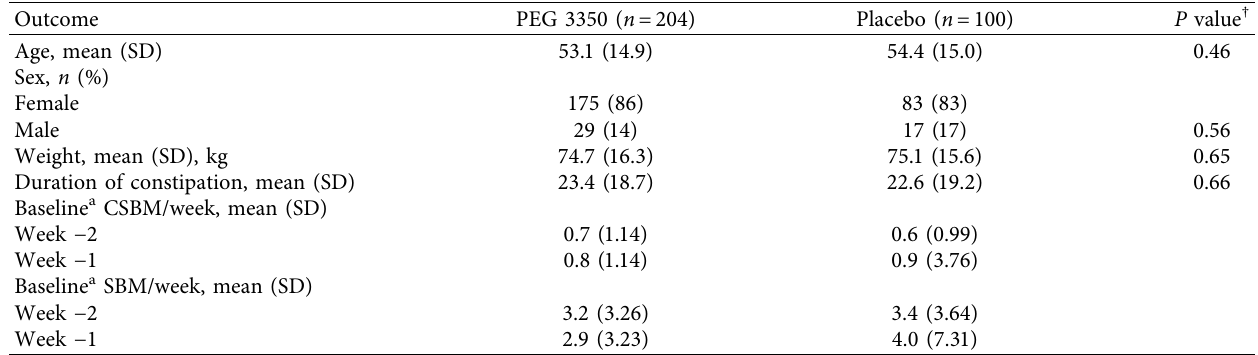
Table 1: Demographics and baseline characteristics.